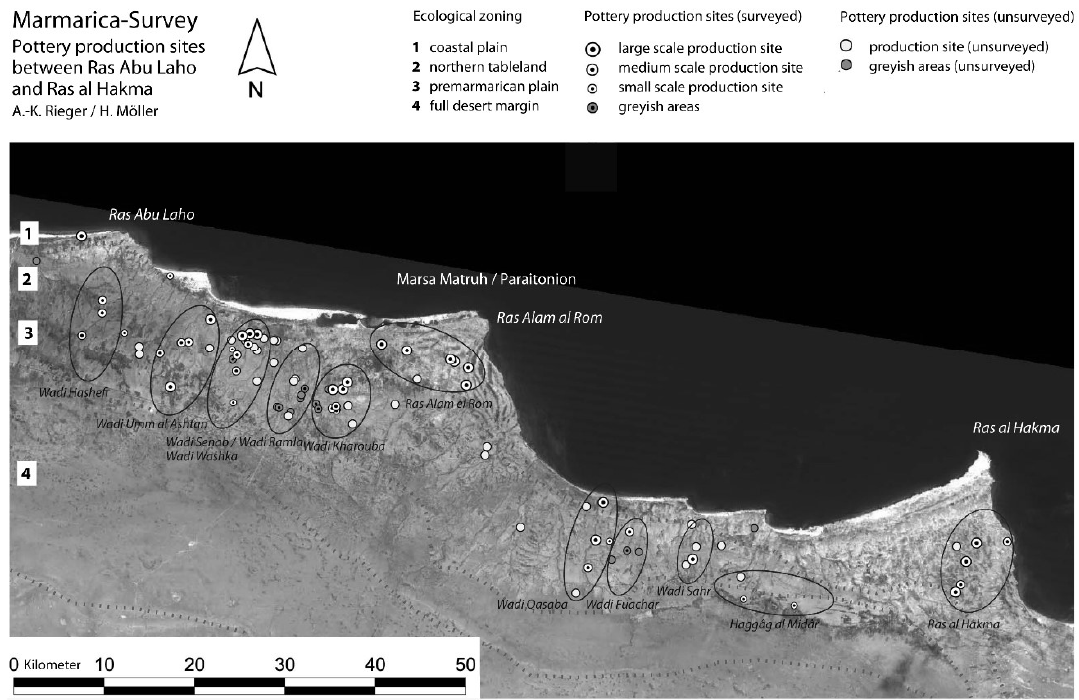
Figure 16. Pottery production sites in Eastern Marmarica. Map: H. Möller; A.-K. Rieger based on Landsat 5TM 179-38.